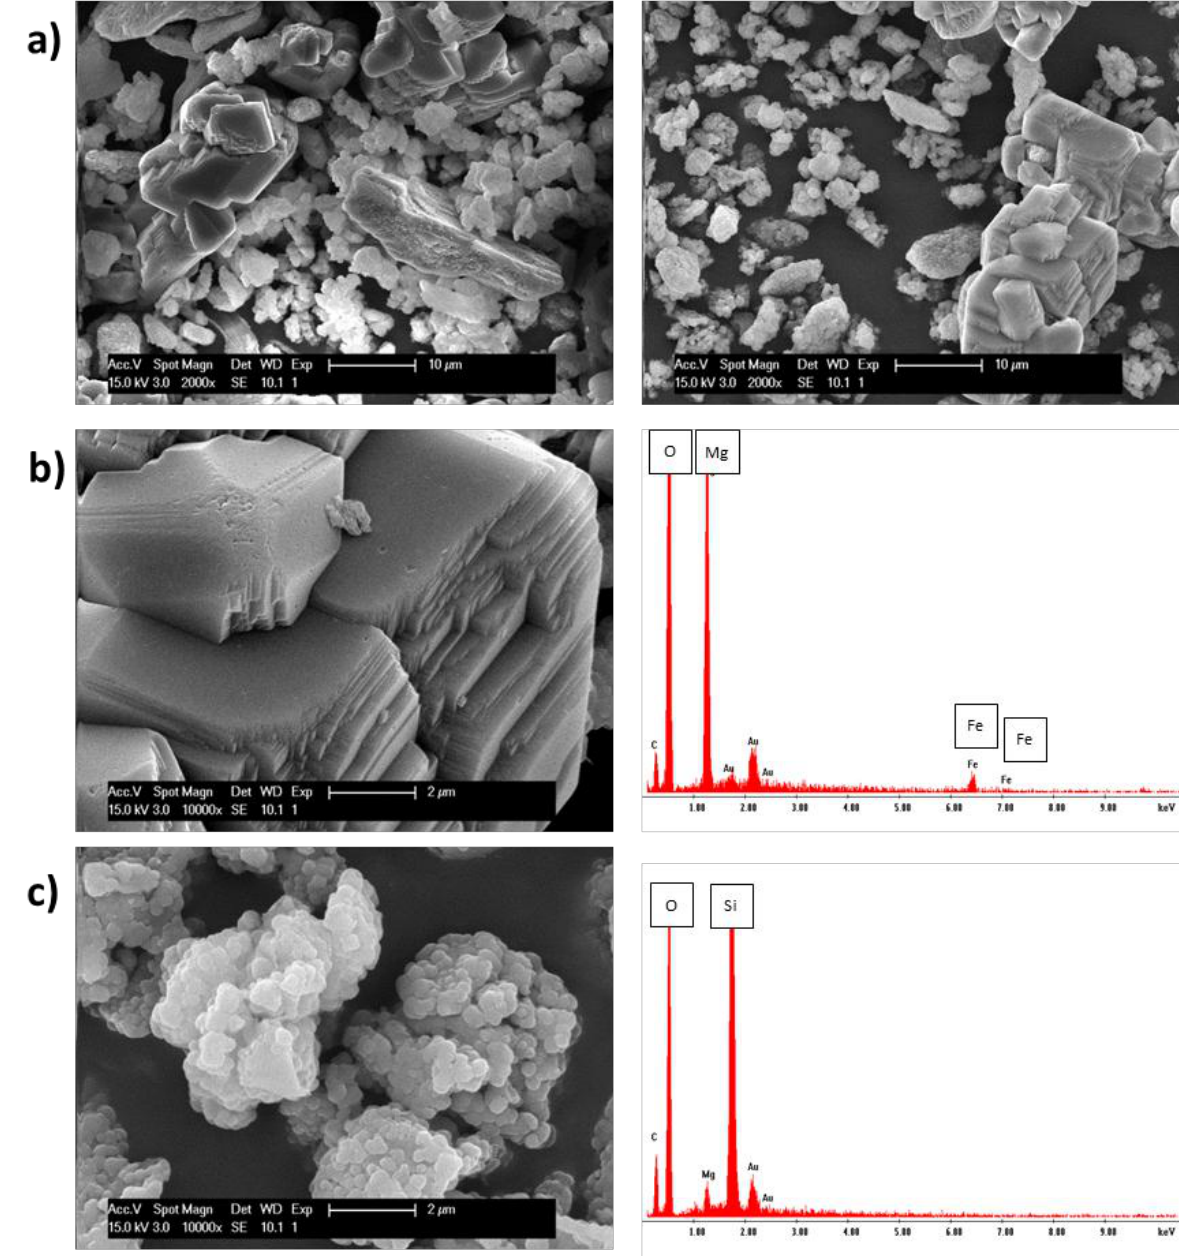
Figure 5. SEM and EDX analyses of individual fully carbonated olivine particles: ( a ) fully carbonated olivine at low magnification; ( b ) ferro-magnesite crystal; ( c ) colloidal silica cluster. Note that Au and C signals are also attributable to gold coating and carbon